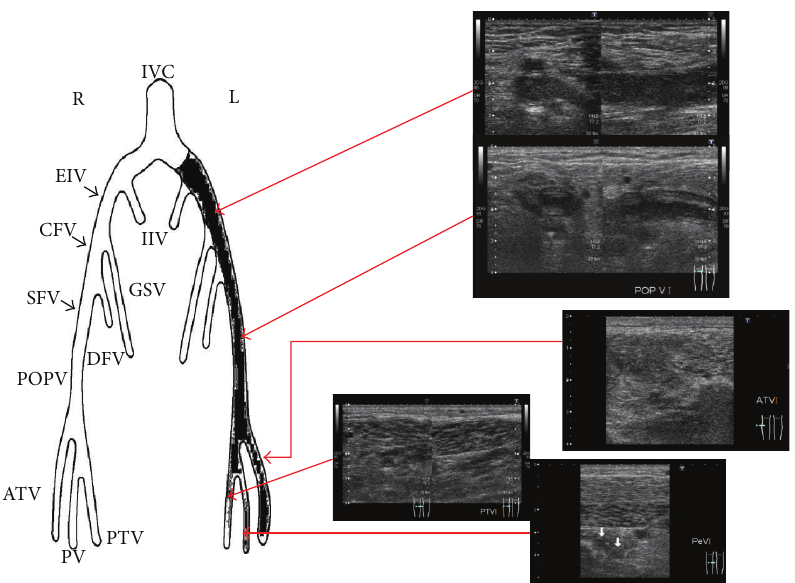
Figure 1: Ultrasonography showed the left iliac vein was occluded with a thrombus.